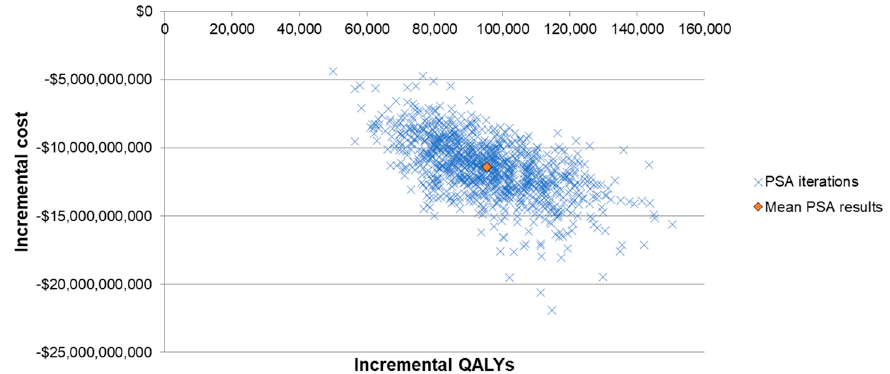
Figure 3. Scattered plot of probabilistic sensitivity analysis. Abbreviations: QALY = quality-adjusted live year; PSA = probabilistic sensitivity analysis.